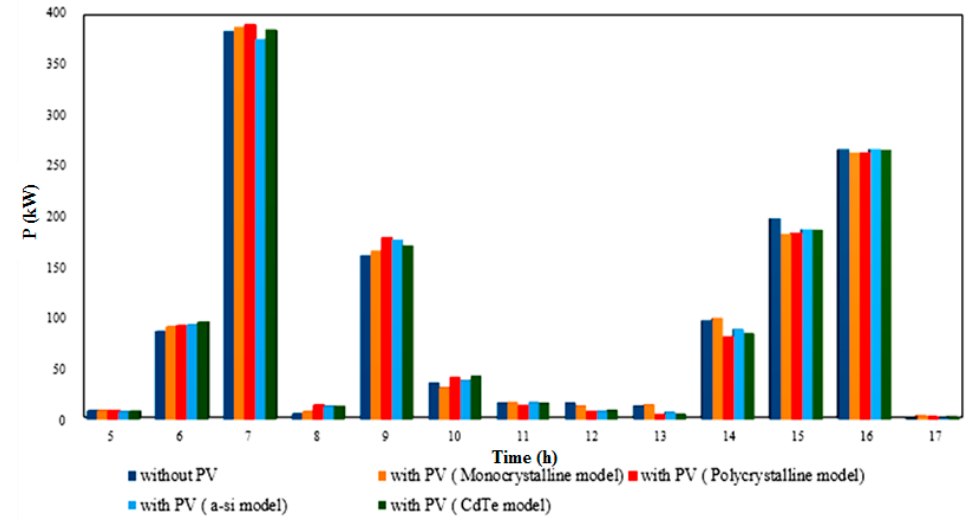
Figure 12. Discharging energy from PL to DSO in November.